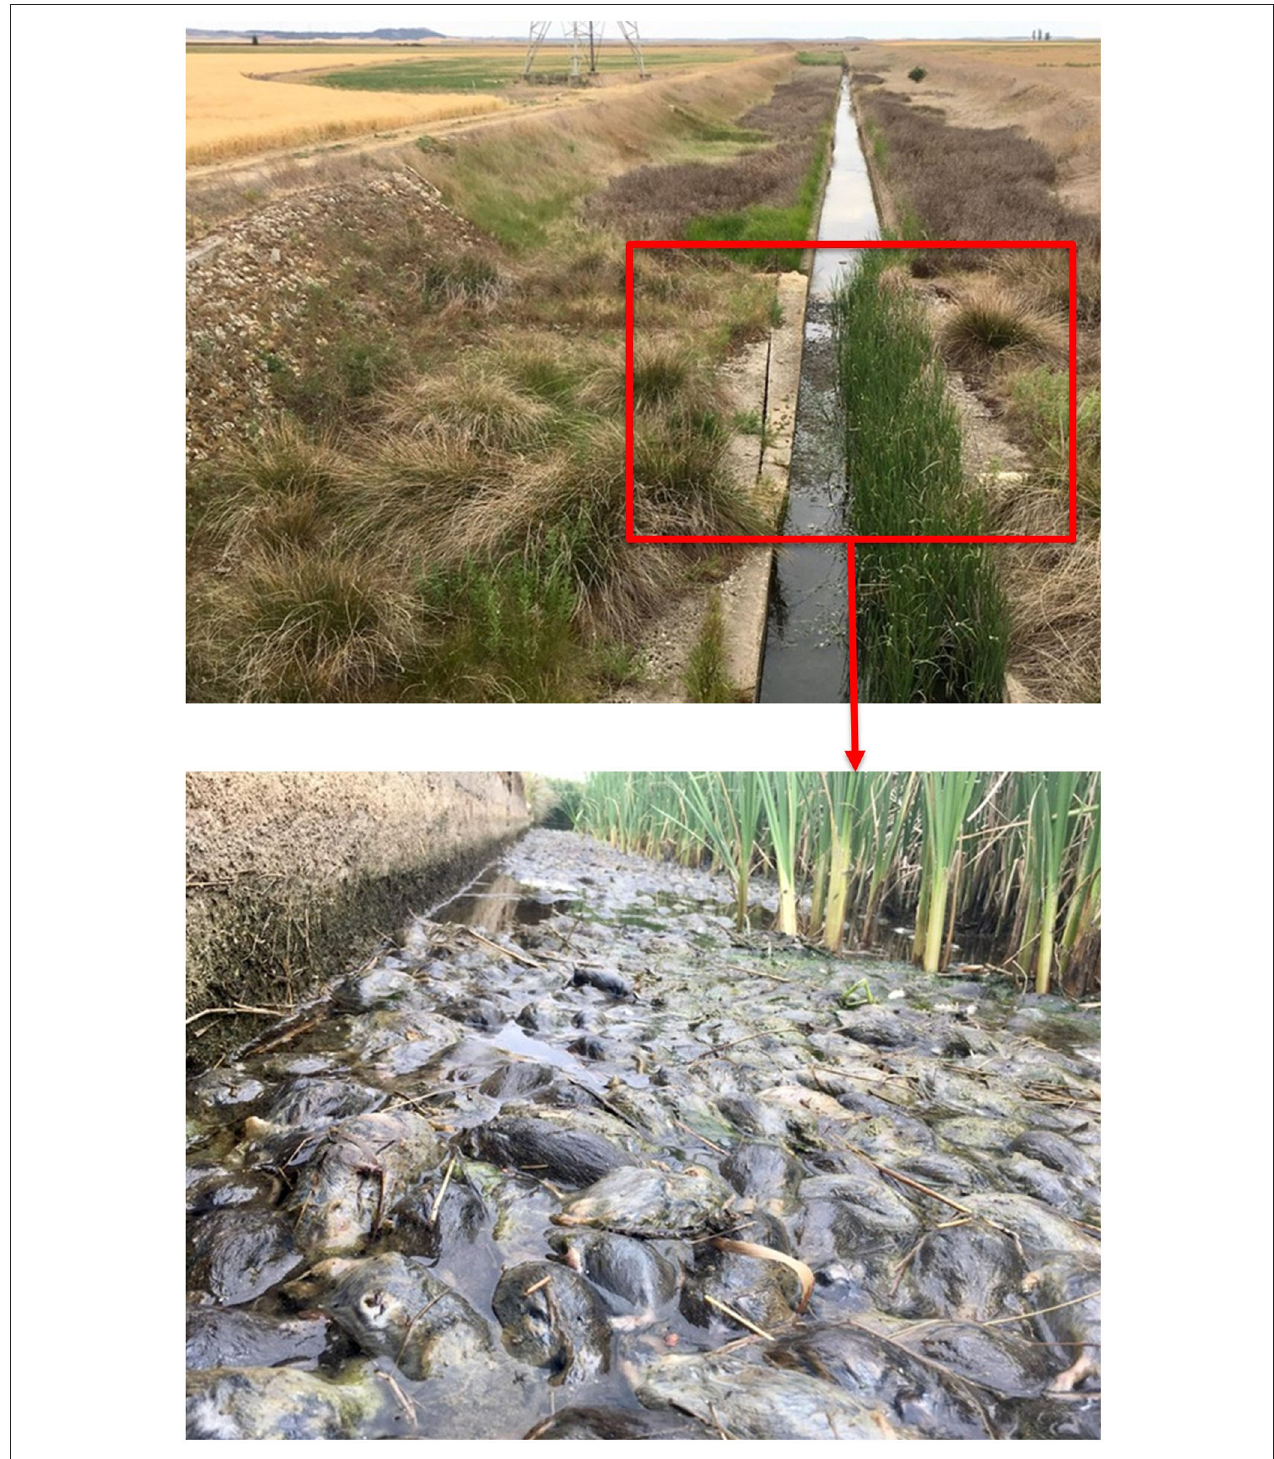
rodent. Unfortunately, we lack data about tularemia prevalence before and during the range shift, hindering the evaluation of